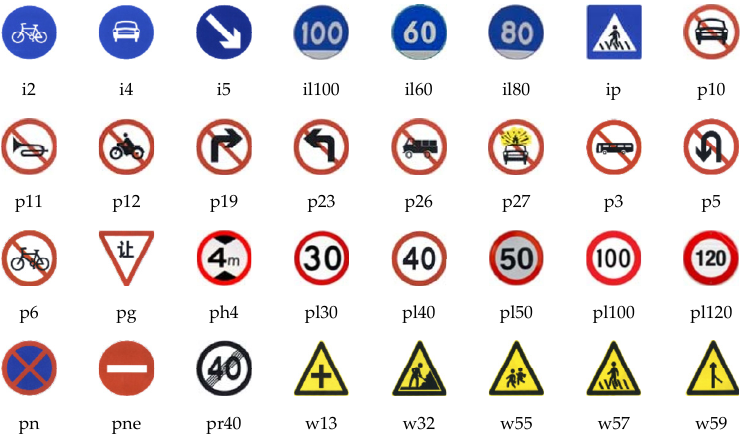
Figure 4. Some traffic sign categories.